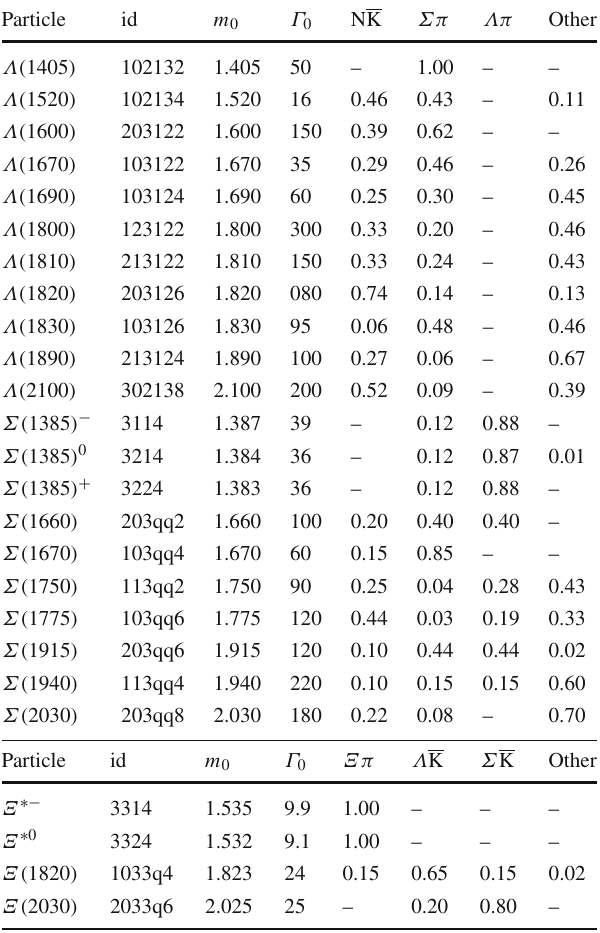
Table 8 Implemented strange baryon resonances, including nominal mass (GeV) and width (MeV), and branching ratios for some main decay